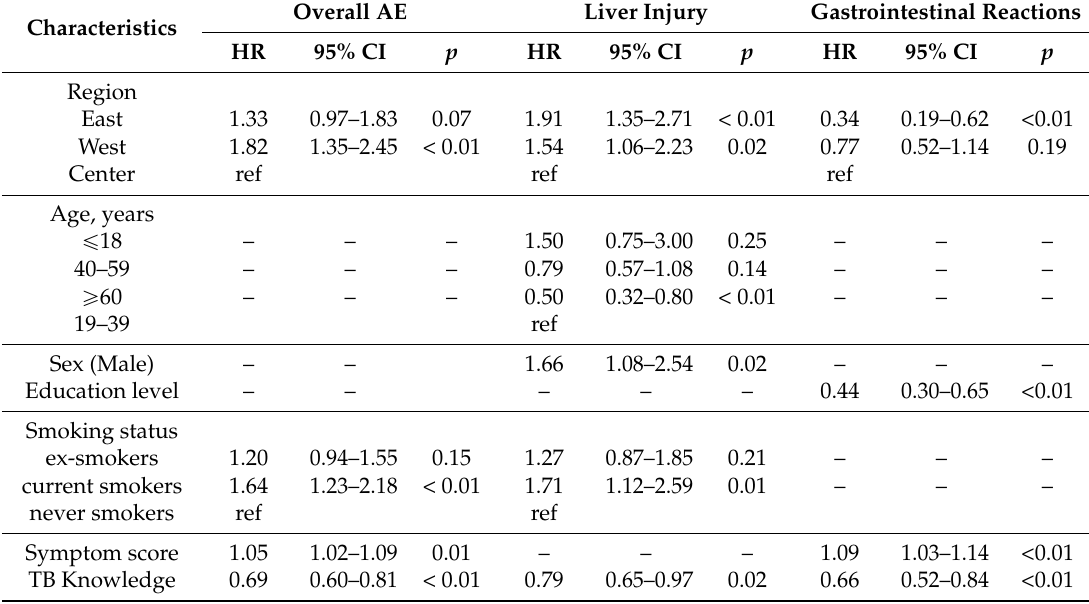
Table 3. The adjusted hazard ratios (HR) of risk factors for adverse events (AE) in multivariable analyses.